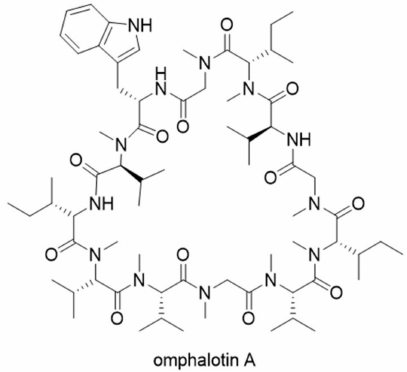
Figure 5. Structure of omphalotin